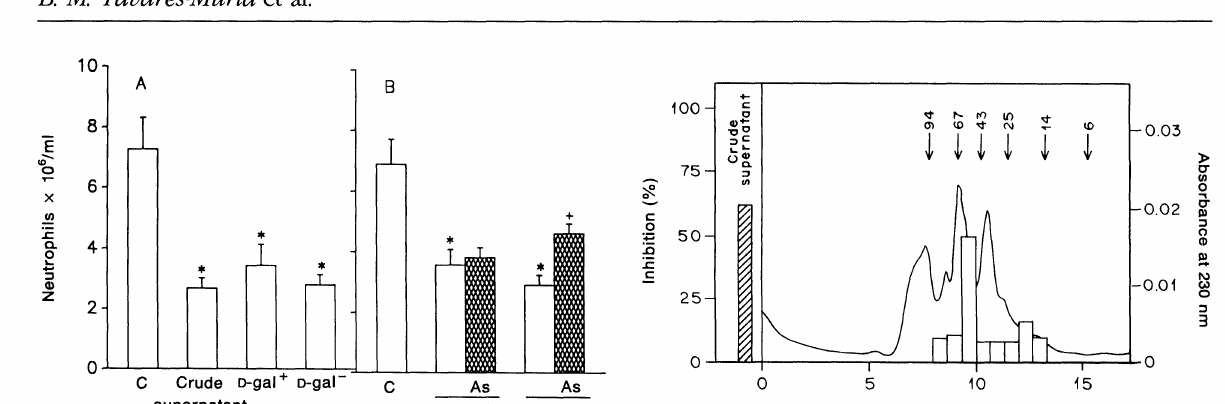
FIG. 1. Inhibitory action of crude supernatant and D-galactose fractions on neutrophil migration and the effect of anti-TNF- and anti-lL8 antisera. The columns indicate the neutrophil migra- tion induced 4h after the i.p. administration of carrageenin (3001g) in rats pretreated (30min) with i.v. injections of PBS (C, control), LPS-stimulated macrophage supernatants (crude super- natant), and D-gal or D-gal- fractions incubated with (panel B) or without (panel A) the antisera (As). In panel B, the D-galactose fractions were co-incubated with sheep antisera (20 t1/200 !1 of sample) against mrTNF- and hrlL-8 for 30min. In both panels, the crude supernatant or D-galactose fractions were obtained from 6 x 106 macrophages. Panel A: *p < 0.01 com- pared to control (ANOVA + Bonferroni). Panel B: *p < 0.01 com- pared to control, + p < 0.05 compared to D-gal- alone (ANOVA + Student’s t-test).